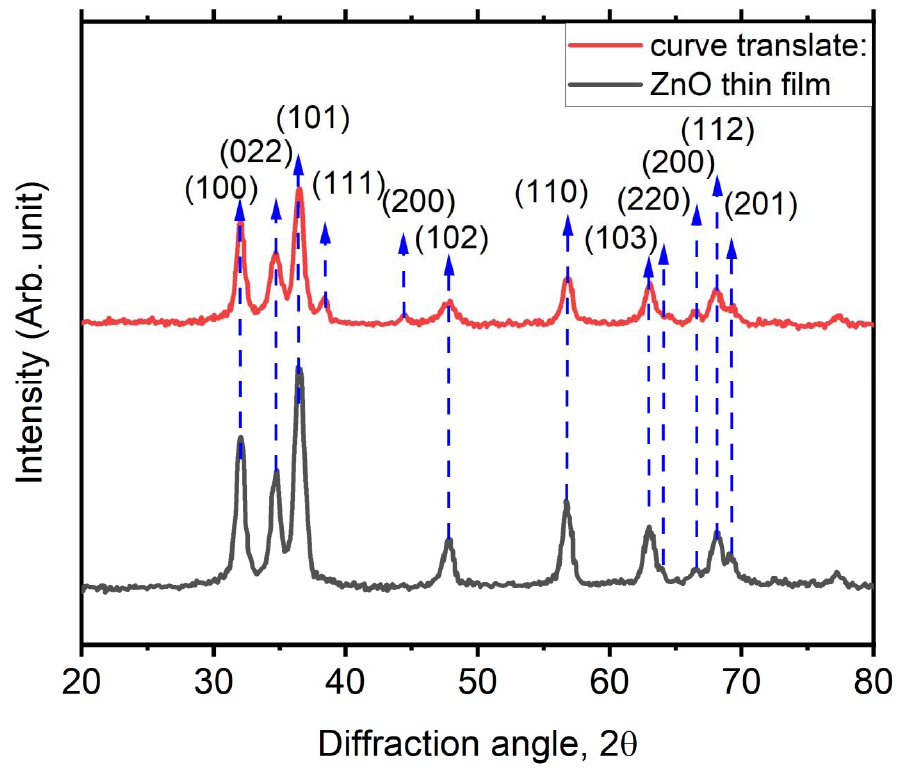
Figure 2. XRD diffractogram of ZnO thin film before and after being embedded with Ag thin films .